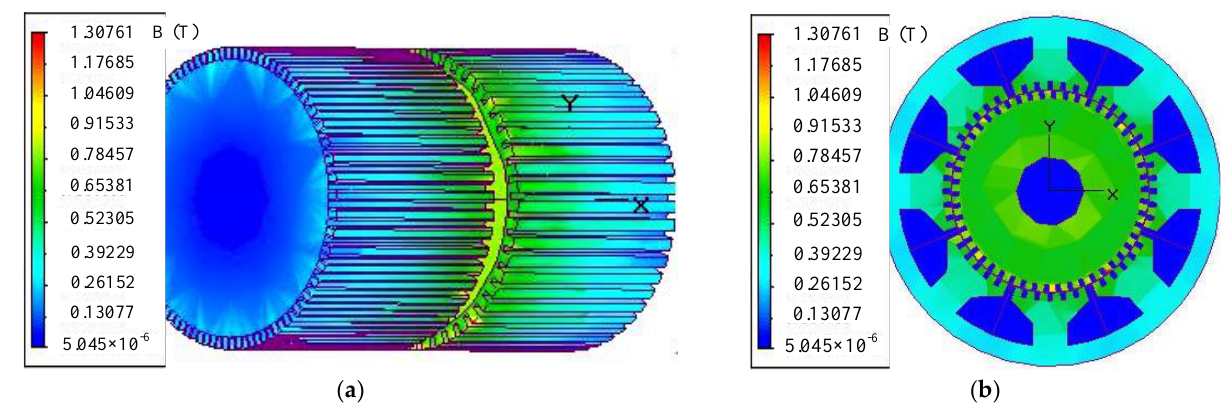
Figure 4. Mesh shape and distribution of magnetic flux density. ( a ) Mesh division of the dual-re- dundancy HSM. ( b ) Magnetic flux density of the dual-redundancy HSM . It can be seen from Figure 4 that the magnetic flux density of the motor was relatively small. The rotor was analyzed; the results are shown in Figure 5. As excepted, the mag- netic flux density near the tooth layer is relatively large.